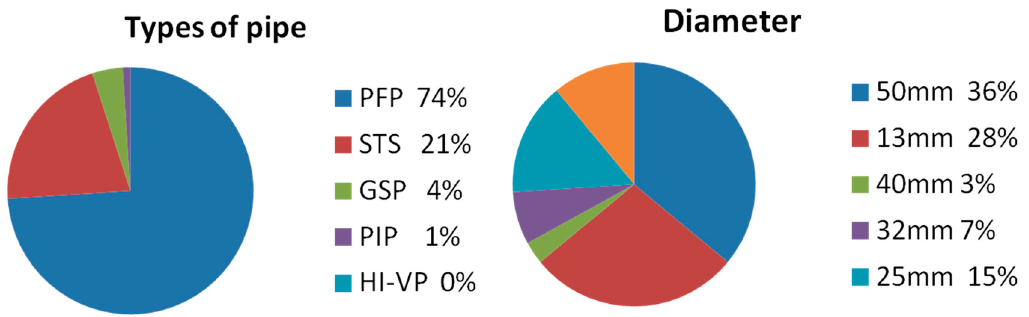
Figure 8. Characteristics of water distribution pipes.